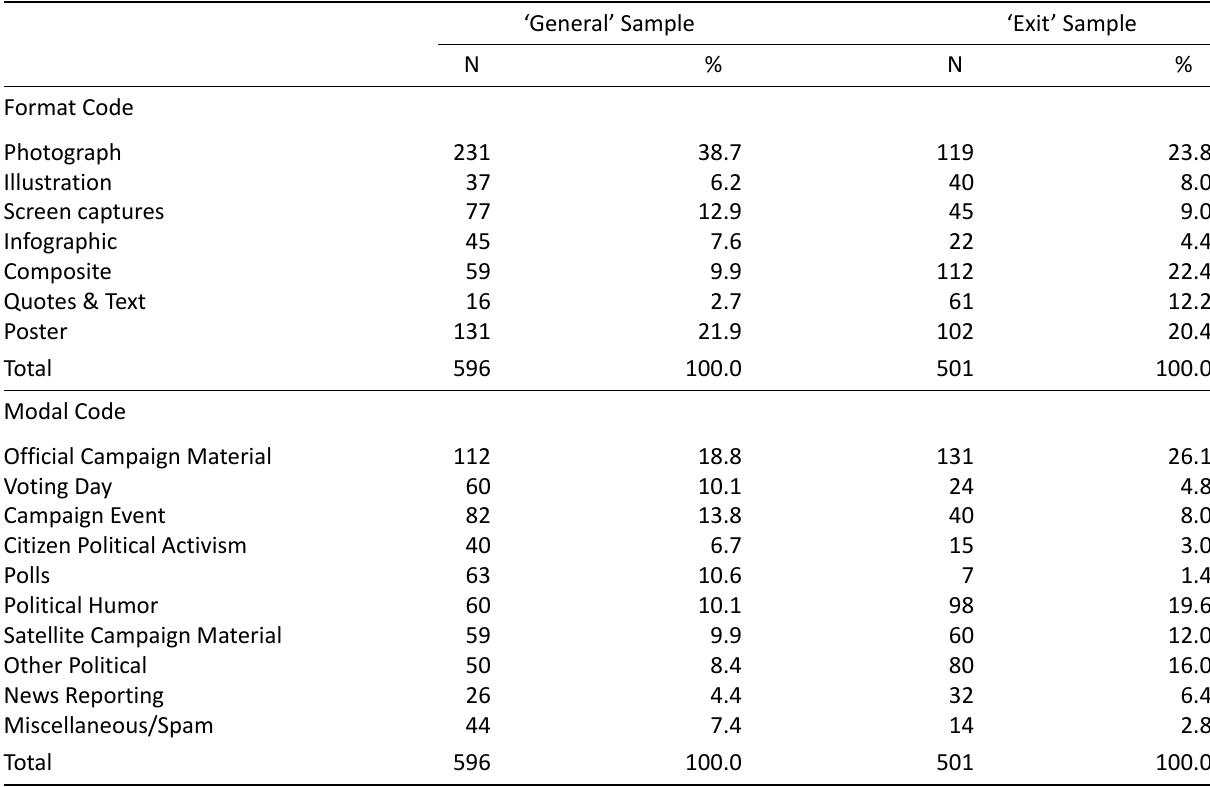
Table 1. Frequency of visual formats and modes across both